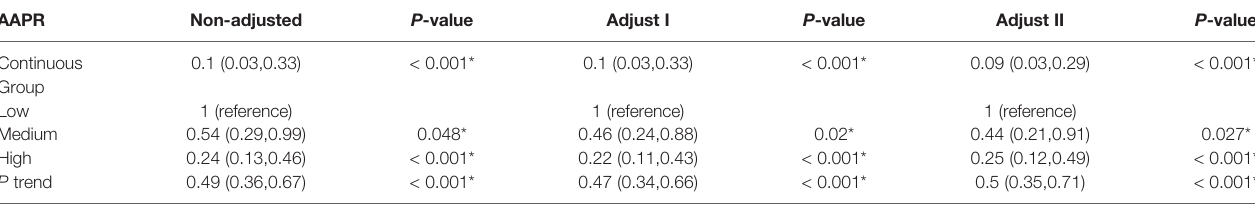
TABLE 3 | Multiple Cox regression analysis of AAPR in patients with BC.